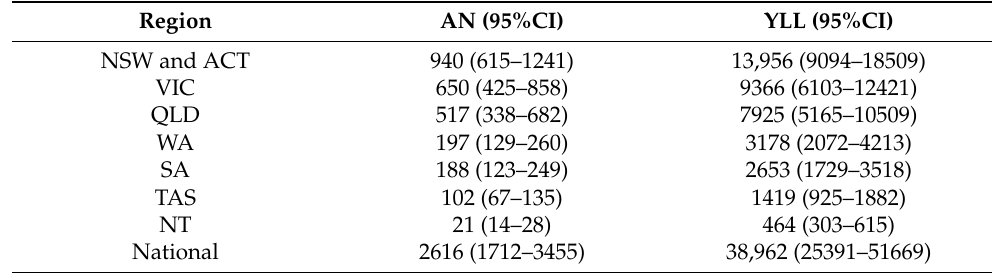
Table 2. Average annual mortality burden; Attributable Number (AN) of premature deaths and Years of Life Lost (YLL) in each Australian state and territory; NSW, New South Wales; ACT, Australian Capital Territory; VIC, Victoria’ QLD, Queensland; WA, Western Australia; SA, South Australia; NT, Northern Territory. Region AN